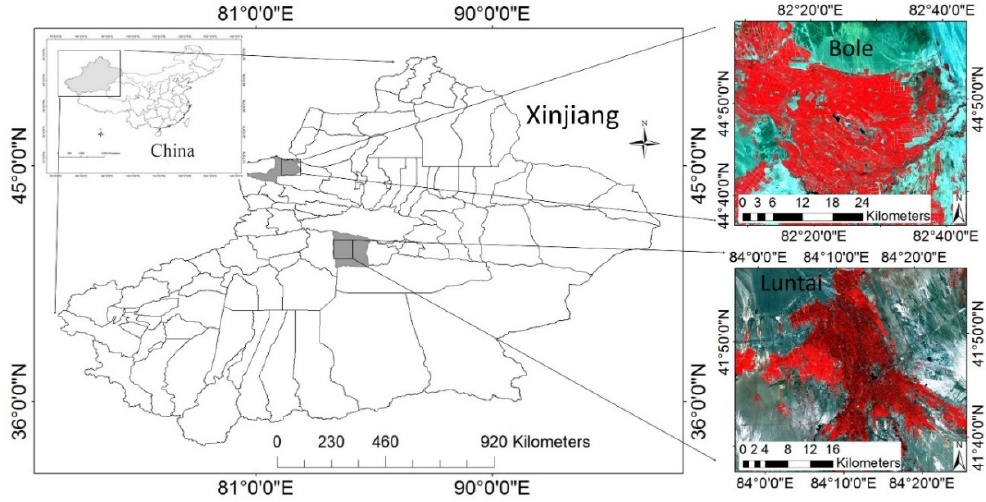
Figure 1. Locations of the study areas.